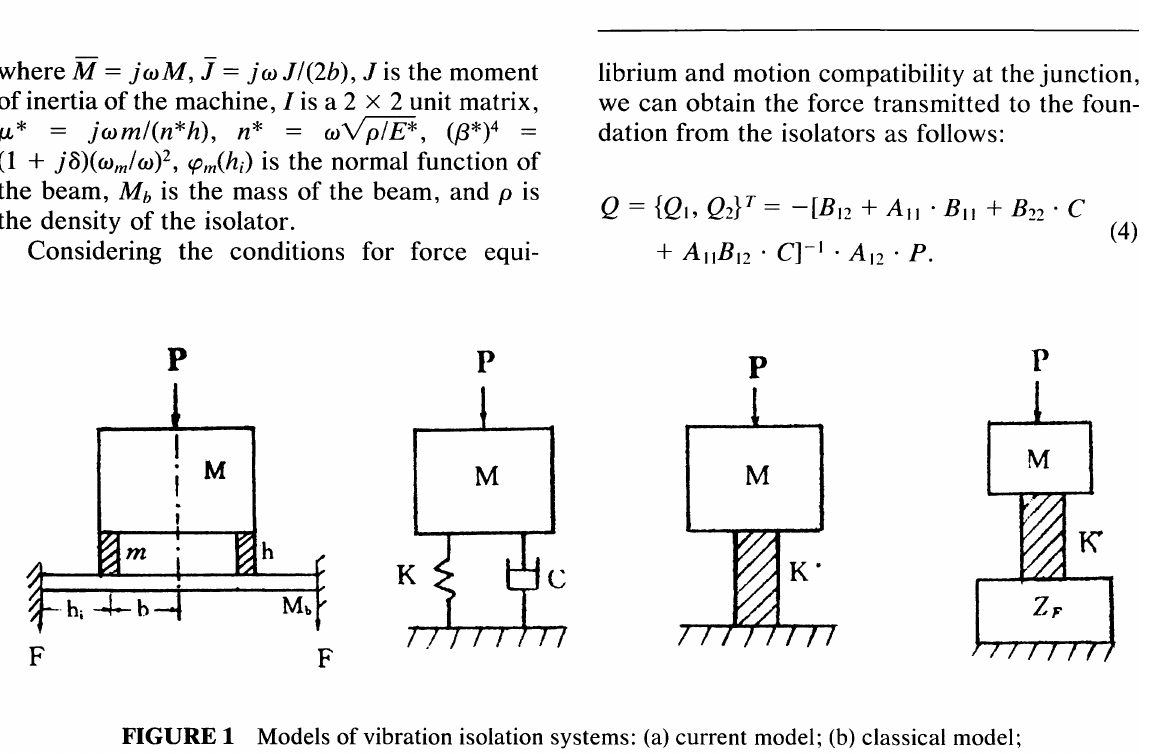
FIGURE 1 Models of vibration isolation systems: (a) current model; (b) classical model; (c) Harrison's model; (d) Snowdon's